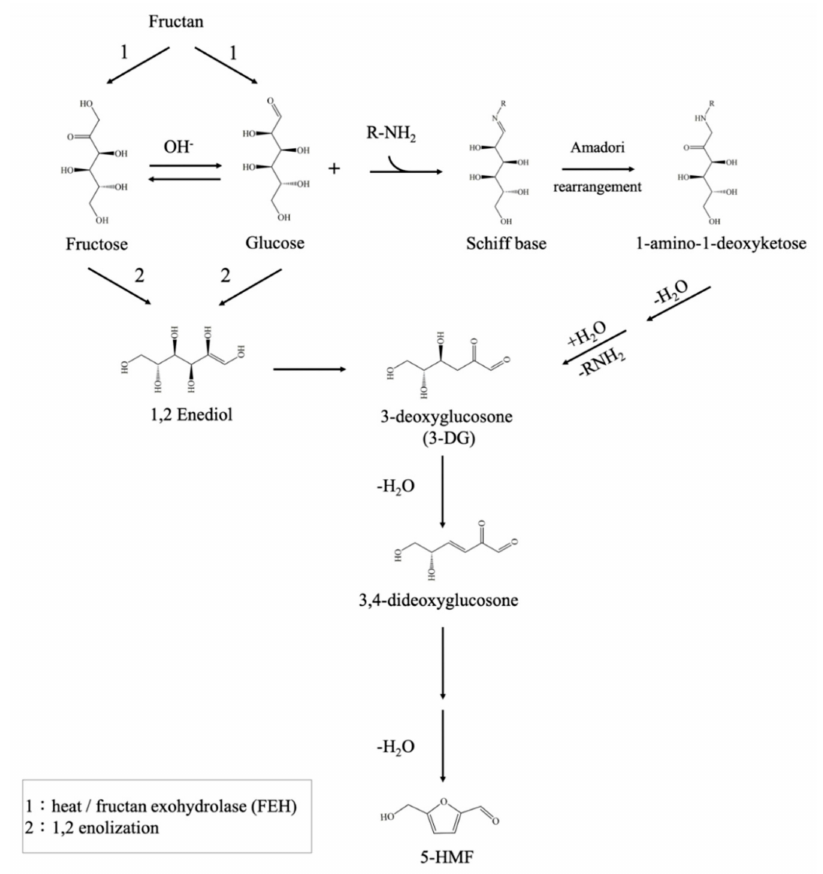
Figure 1. Mechanism of 5-HMF formation in black garlic